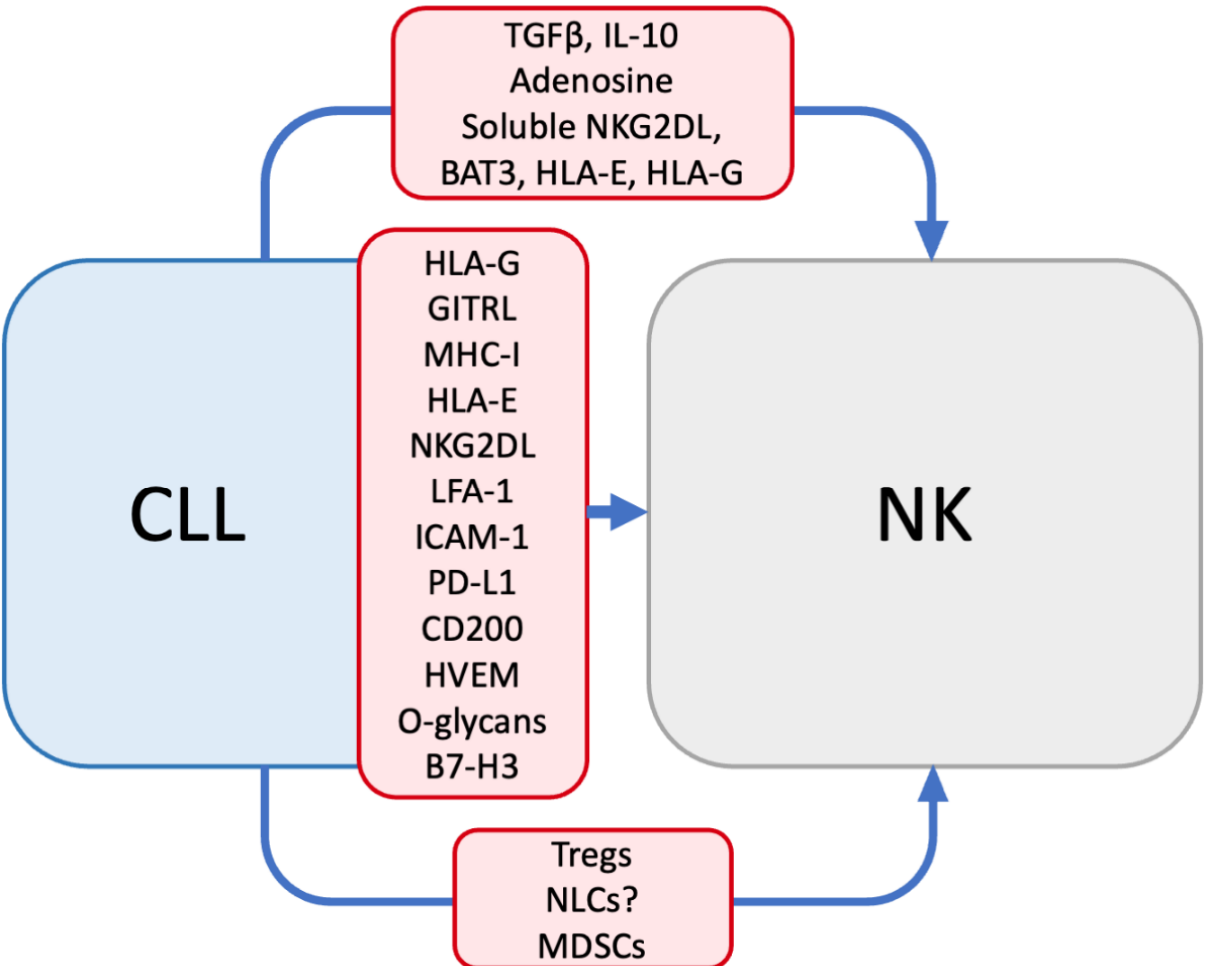
Figure 2. Mechanisms of CLL-induced NK suppression. NK dysfunction seen in CLL patients is ascribed to multiple mechanisms, including soluble factors (cytokines, metabolites, ligands), surface ligand expression, and altered immune populations (Tregs, NLCs, MDSCs).